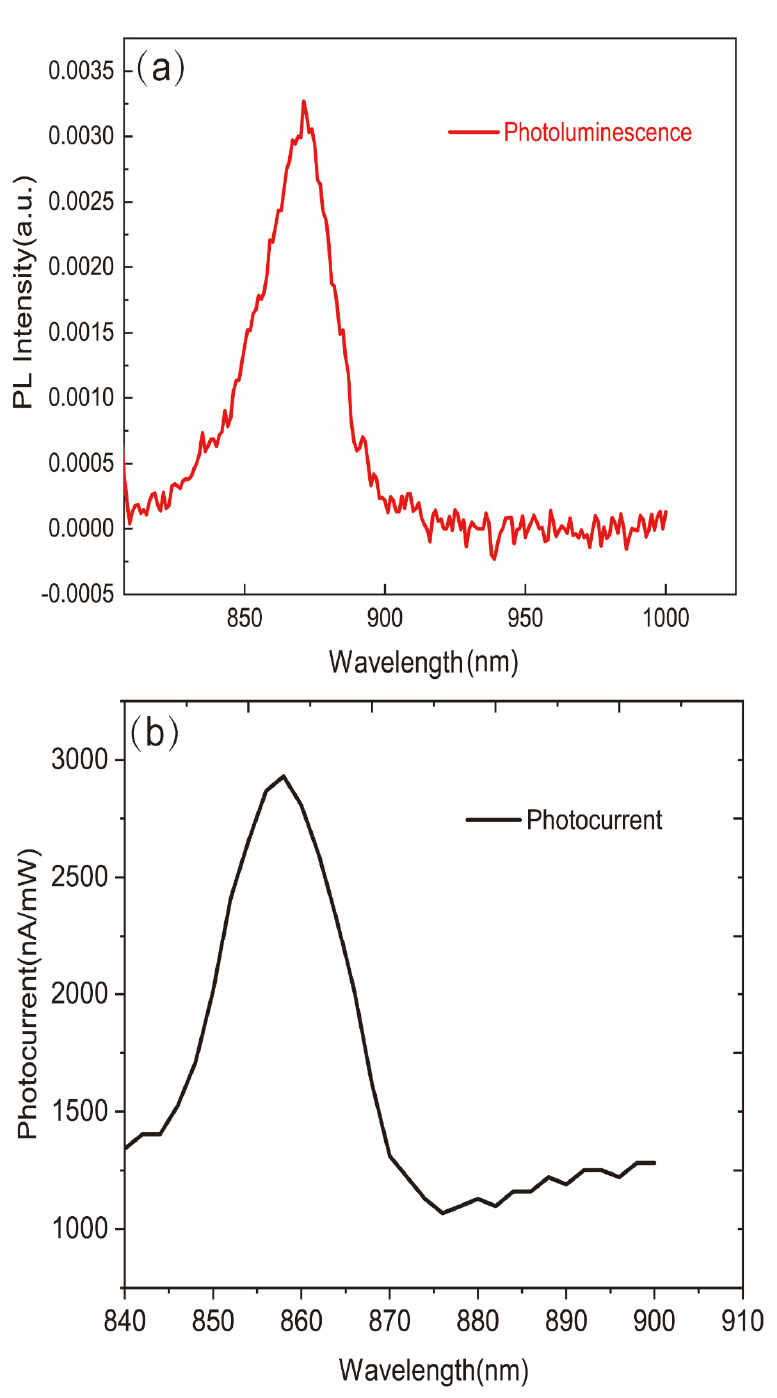
Figure 3. ( a ) The photoluminescence spectrum of p-GaAs; ( b ) the photocurrent spectrum of p-GaAs under 0.1 V.